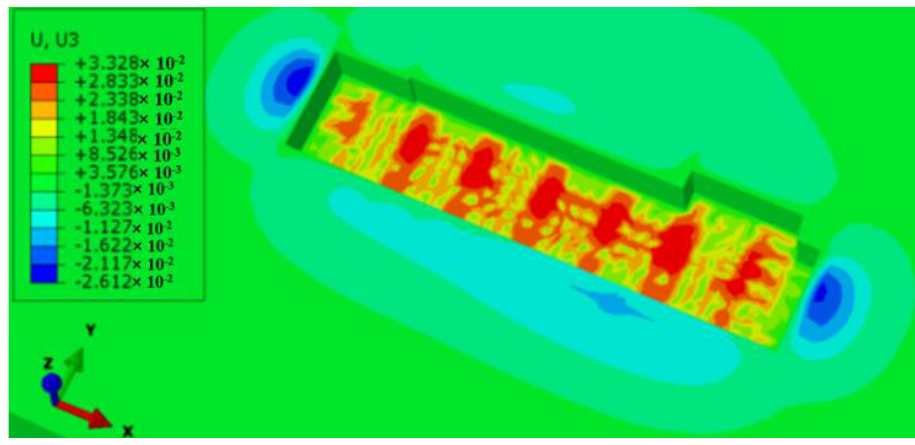
Figure 10. Distribution of vertical displacement at the bottom of the excavation (unit: